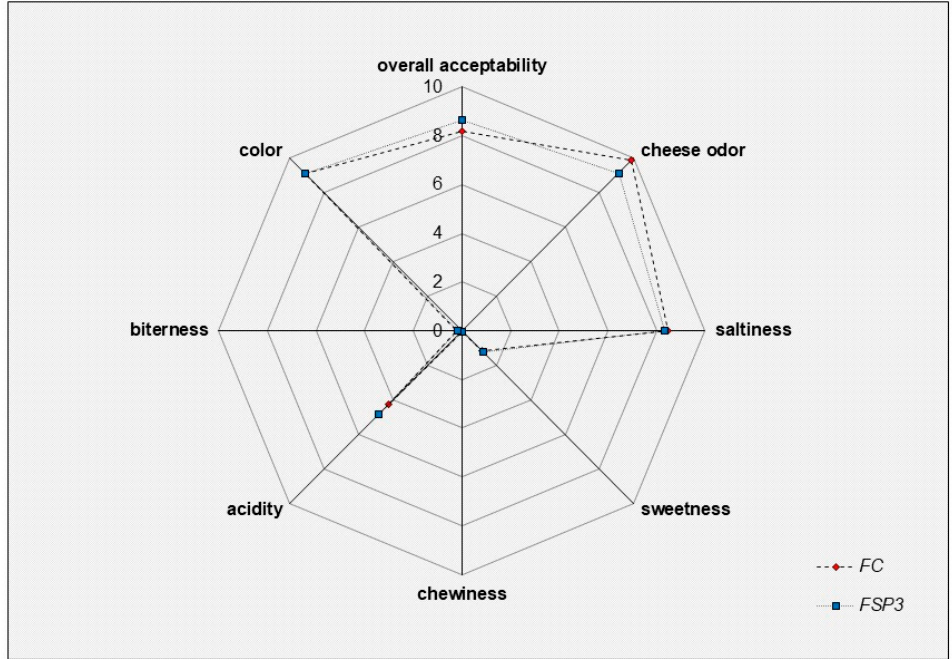
Figure 2. Sensory evaluation of produced Feta-type chesses presented as a spider chart of products attributes. FC : (